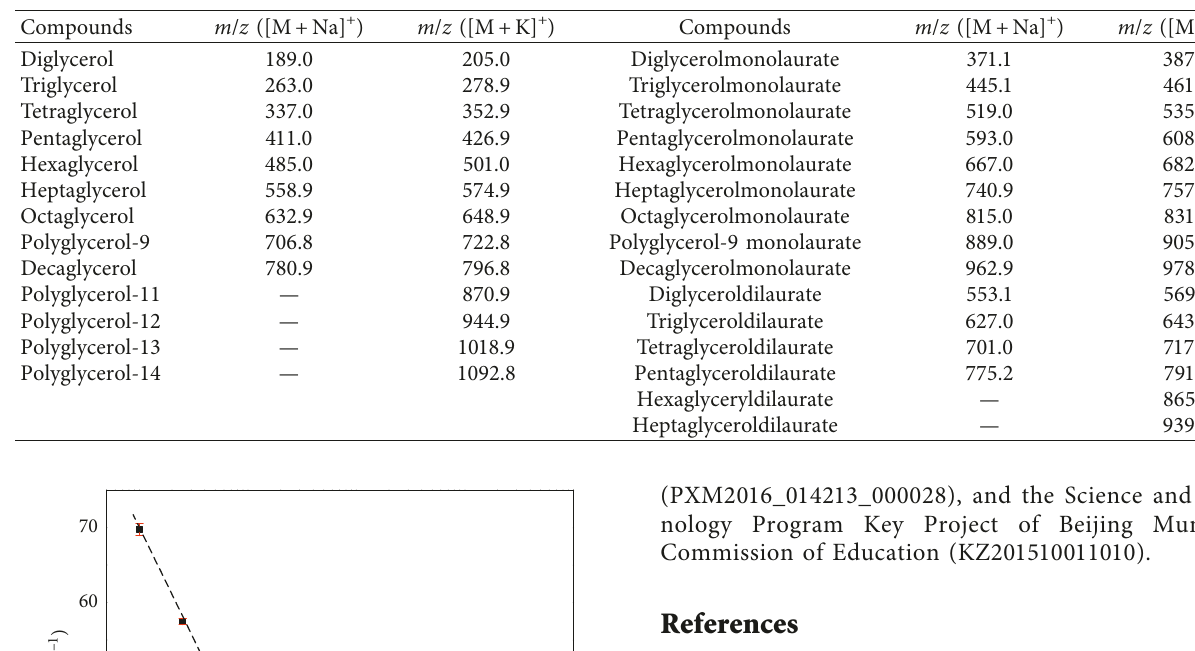
Table 4: Compounds and corresponding m /